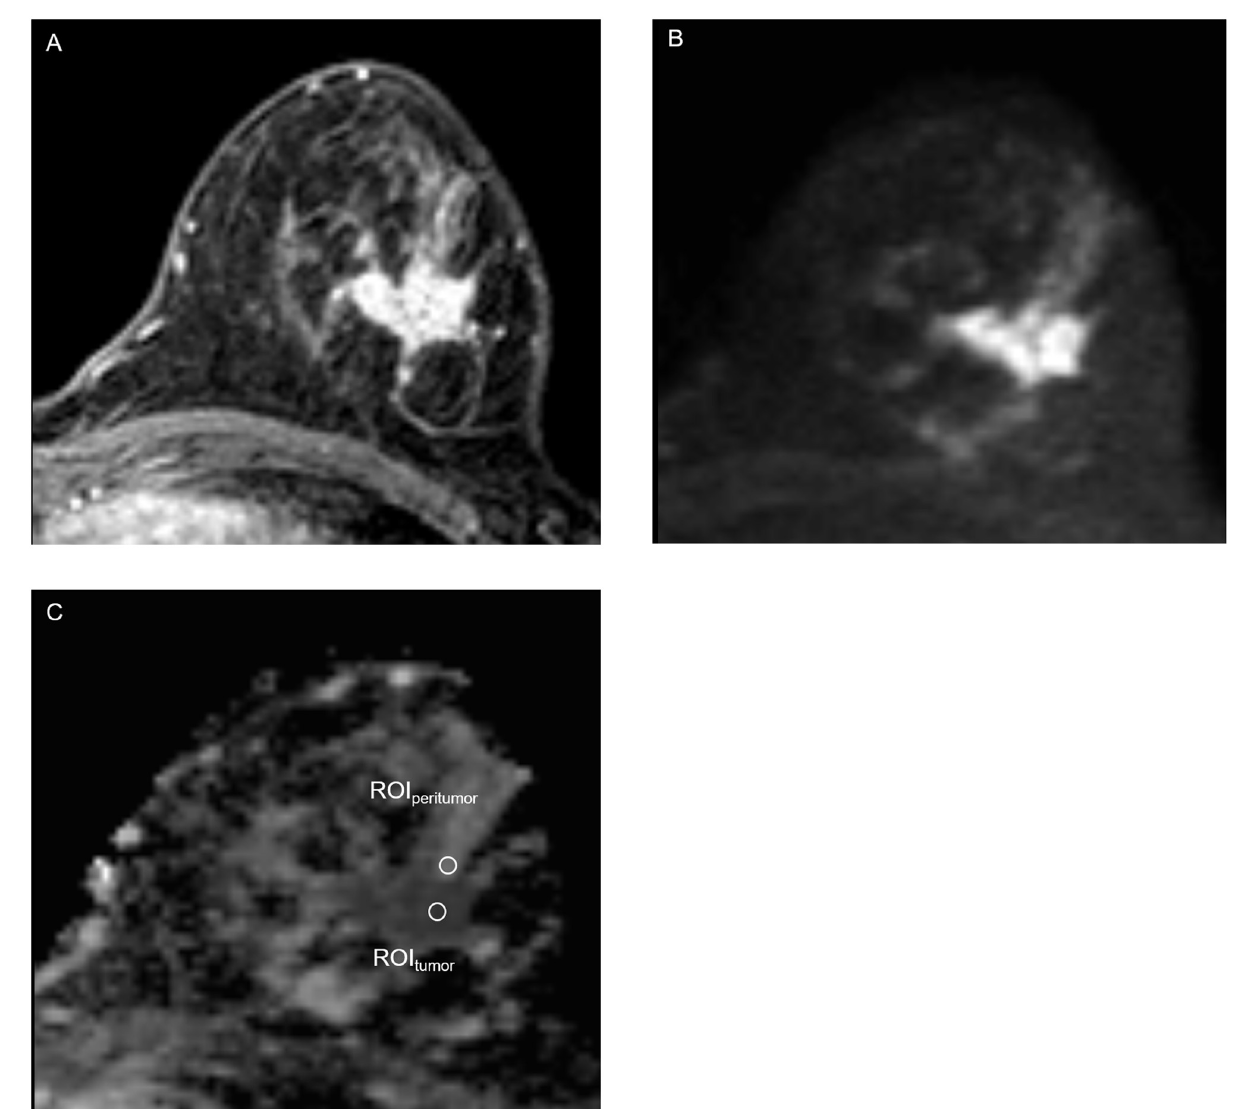
Fig 4. Example of a breast lesion in a 44-year-old female patient with a low peritumor/tumor apparent diffusion coefficient (ADC) ratio. A, Axial T1-weighted gadolinium-enhanced thin slice source image shows an irregular heterogeneously enhancing mass in the left breast; B, High intensity signal is shown in axial diffusion-weighted image ( b value = 800 s/mm 2 ); C, ADC map shows restricted diffusion in the mass. The lowest mean tumor ADC value (shown as ROI tumor ) was 0.69 × 10 − 3 mm 2 /s and the highest mean peritumor ADC value (shown as ROI peritumor ) was 1.32 × 10 − 3 mm 2 /s. The peritumor/tumor ADC ratio was 1.91. The clinical and histopathological features of the lesion were: pT2N0sn, grade 3, human epidermal growth factor receptor 2 positive, estrogen receptor and progesterone receptor positive, Ki-67 high ( � 20%), lymphovascular invasion positive. The patient underwent mastectomy and sentinel lymph node biopsy. https://doi.org/10.1371/journal.pone.0235278.g004 cancers was separately calculated for each dichotomized histopathological parameter. The optimal threshold values were first selected using Receiver Operating Characteristics analysis. Sensitivity, specificity and positive likelihood ratios (LR+) were then calculated for those histo- pathological parameters with statistical significance in univariate analysis. The Kaplan-Meier method with log rank (Mantel-Cox) test was used to compare survival in dichotomized groups of tumor ADC values ( � or < 0.50 × 10 − 3 mm 2 /s), peritumor ADC values ( � or < 1.75 × 10 − 3 mm 2 /s) and peritumor/tumor ADC ratios ( � or < 3.5). The correlations between tumor ADC